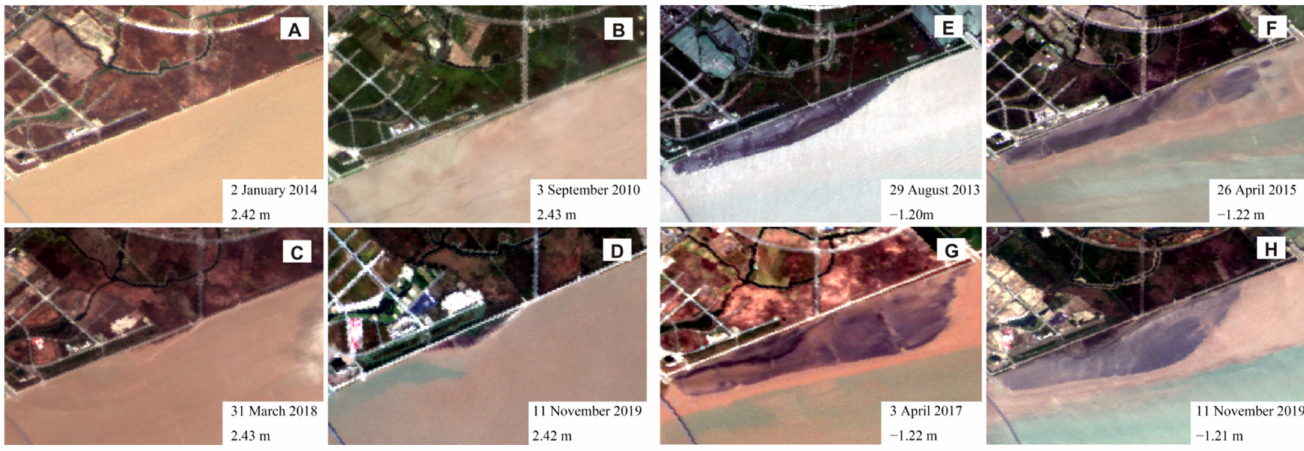
Figure 3. The satellite images acquired at the high tidal level in ( A ) 2014, ( B ) 2016, ( C ) 2018, and ( D ) 2019 and the corresponding range of the tidal levels from 2.42 m to 2.43 m (based on the mean sea level) and at the low tidal level in ( E ) 2013, ( F ) 2015, ( G ) 2017, and ( H ) 2019, and the corresponding range of the tidal levels from − 1.22 m to − 1.20